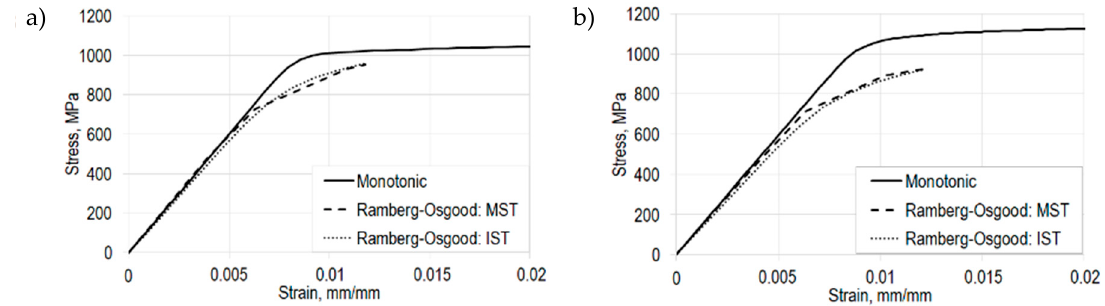
Figure 9. Softening behavior of Ti-6Al-4V for ( a ) vertically oriented specimens and ( b ) horizontally oriented specimens.